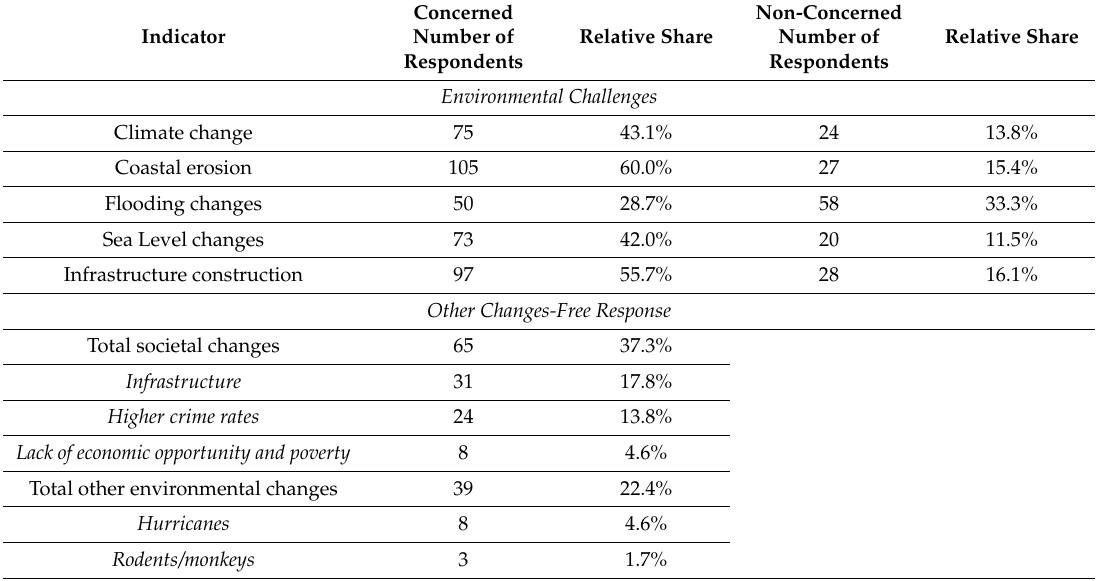
Table 3. Respondents’ perceptions of challenges in St.